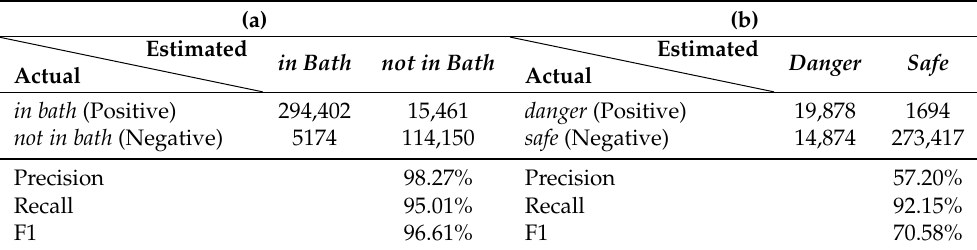
Table 1. Classification results for (a) activity recognition and (b) danger detection